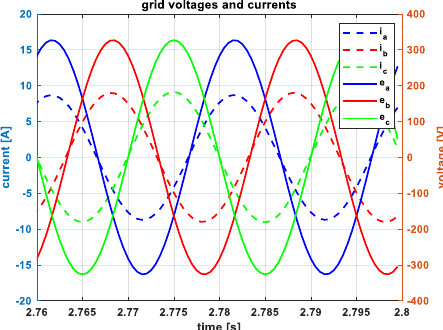
Figure 8. Steady-state behavior of grid currents and voltages.